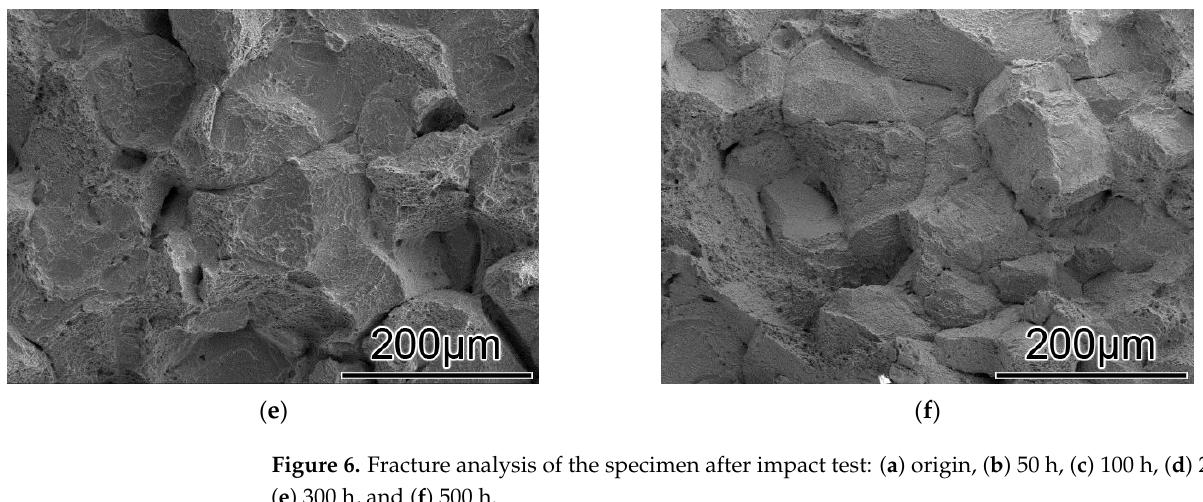
Figure 6. Fracture analysis of the specimen after impact test: ( a ) origin, ( b ) 50 h, ( c ) 100 h, ( d ) 200 h, ( e ) 300 h, and ( f ) 500 h.